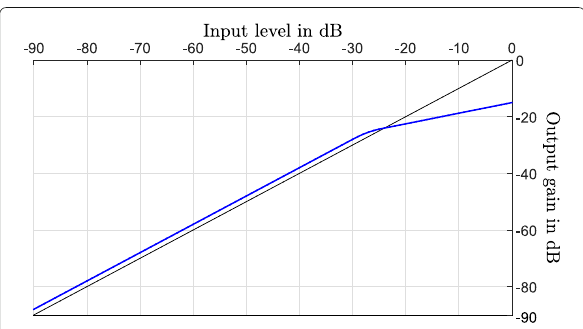
Fig. 15 Compressor characteristic of the loudspeakers in front of the mask